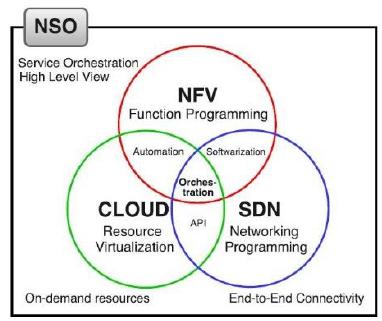
Figure 1. Orchestrator technologies [26].